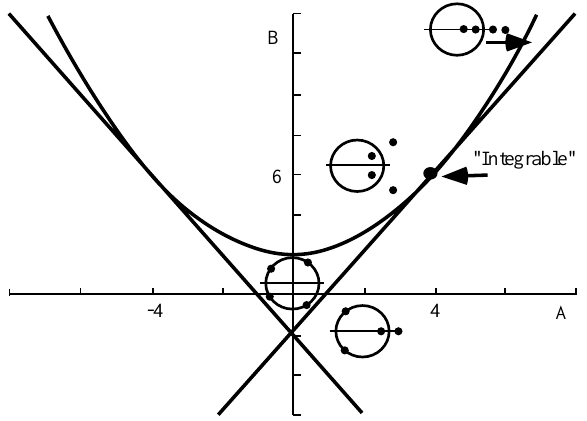
FIG. 2. Linear stability diagram for 4D symplectic